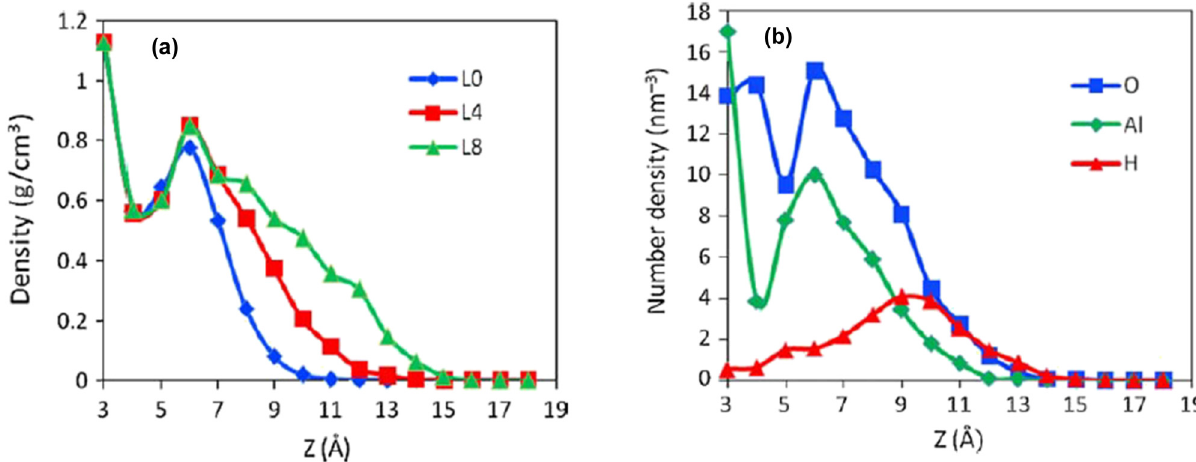
Figure 14: ( a ) Blue line shows the total density pro fi les at 0 ALD cycles, red for four ALD cycles, and green for eight ALD cycles with respect to the Z - direction distance of the Al 2 O 3 fi lm at 300°C [ 186 ] . ( b ) The number density pro fi les for oxygen ( blue ) , aluminium ( green ) , and hydrogen ( red ) as a function of the Z - direction distance of Al 2 O 3 fi lm at 300°C [ 186 ]